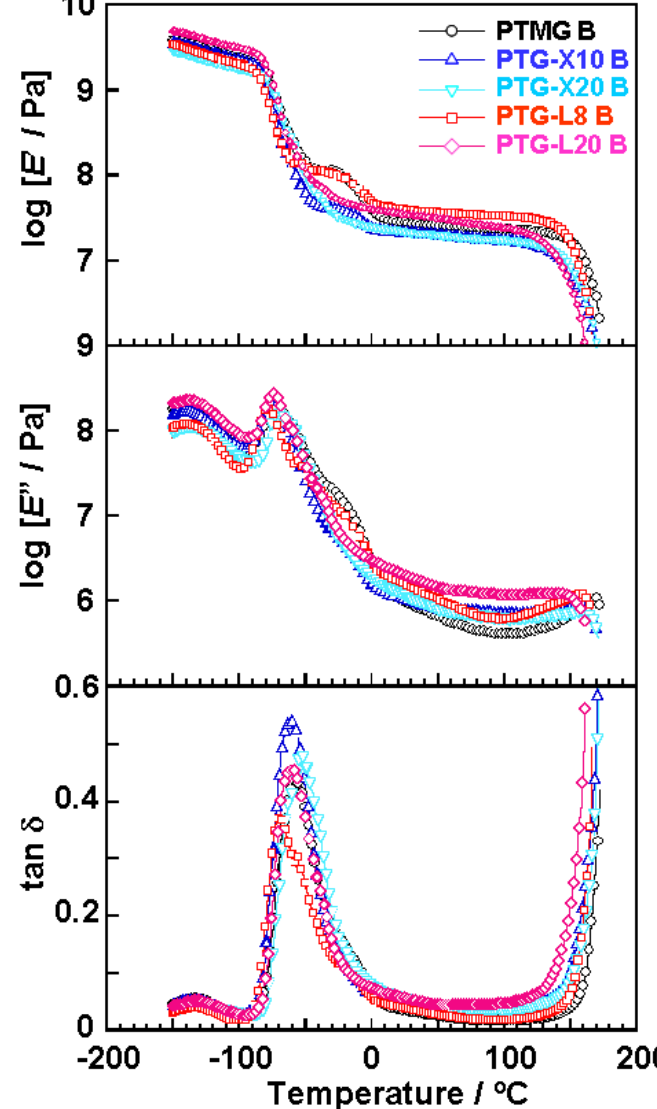
Figure 2. Young’s modulus decreased with increasing side methyl group content. This is because the incorporation of the side methyl group content causes restriction of crystallization of the soft segment chain and a decrease in physically crosslinking points due to a decrease in the degree of microphase separation. On the contrary, tensile strength and elongation at break decreased and increased, respectively. These changes can be attributed to the steric hindrance of dimethyl and methyl groups of the soft segment chains in the expanded state. That is, for PTMG B, PTG-X10 B and PTGL8 B, the soft segment chains can be crystallized well with increasing strain. In contrast, for PTG-X20 B and PTG-L20 B, dimethyl and methyl groups effectively disrupt crystallization of the soft segment and a phase mixing trend causes molecular slipping between the hard segments. Discussion about elongation-induced crystallization will be stated with the result of WAXD measurement. Stress-strain test revealed that introduction of methyl groups to polymer glycol is quite effective not only for the initial property (Young’s modulus) but also the elongated state (tensile strength and strain at break). Figure 3. Temperature dependence of storage modulus ( E ’), loss modulus ( E ”) and loss tangent (tan  ) of PTMG, PTG-X and PTG-L-based PUEs measured at 10